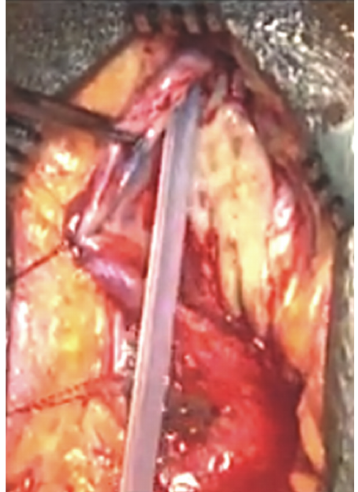
Figure 1: BMG placement in Barbagli technique.